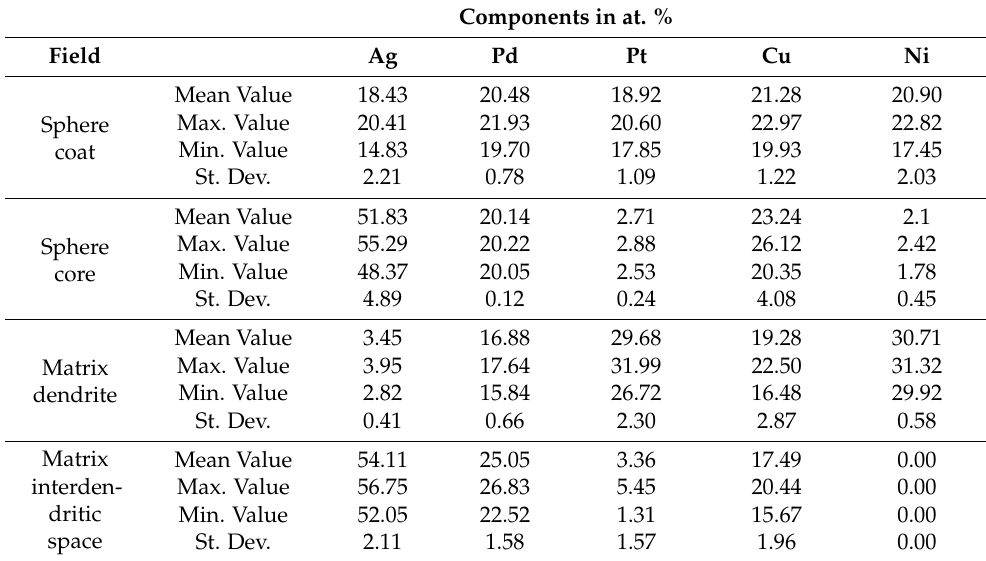
Table 1. EDS chemical analysis of individual fields (at. %) of the cast sample. Components in at.